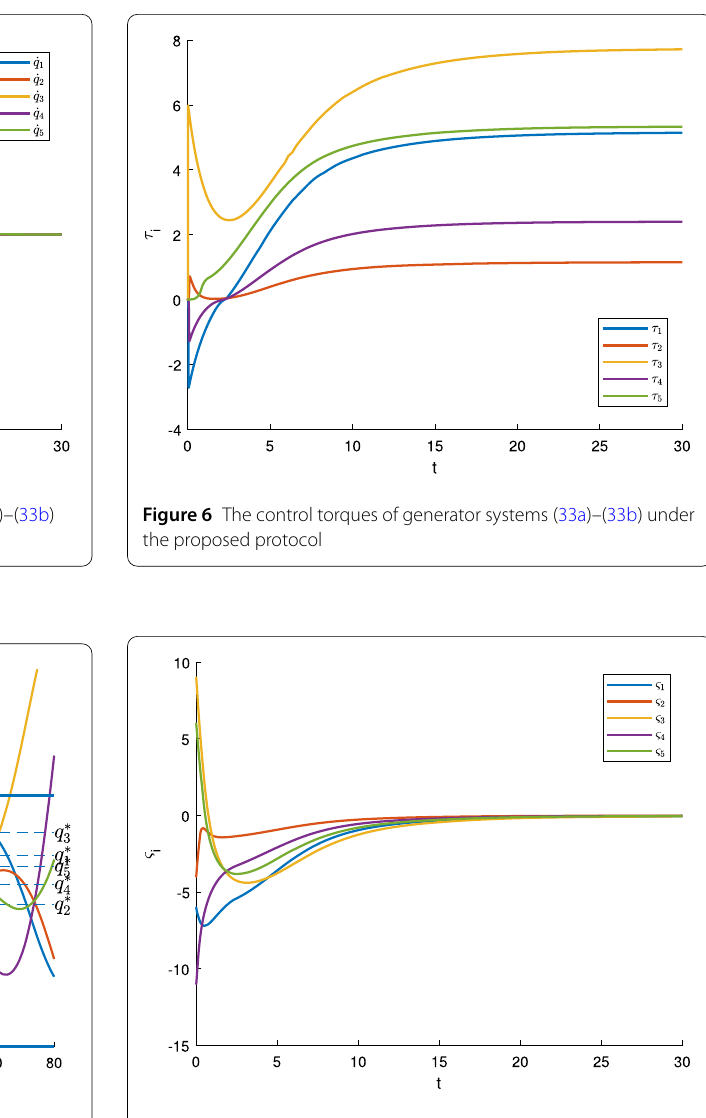
formly continuous. And ( F ( x ) – F ( q ∗ )) T ( x – q ∗ ) = 0 if and